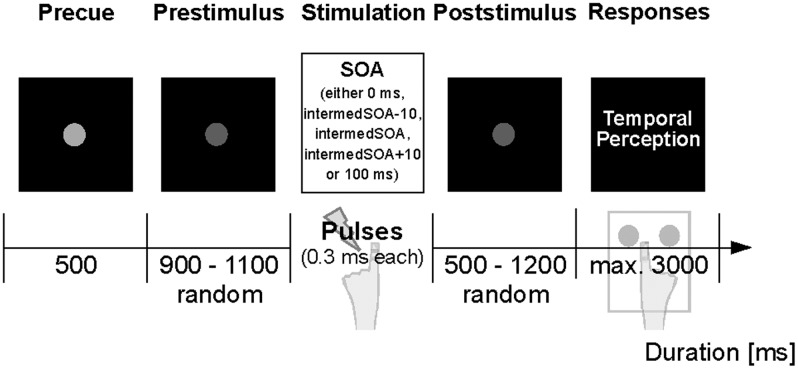
Experimental paradigm. The experiment started with a central fixation dot serving as start cue. A decrease in luminance after 500 ms signaled the start of the prestimulus epoch (jittered period of 900–1100 ms). Subsequently, electrotactile stimulation was applied to the left index finger with varying SOAs (0 ms, intermedSOA-10, intermedSOA, intermedSOA+10, 100 ms). Following a jittered poststimulus period (500–1200 ms), written instructions indicated the response window and subjects had to report their perception of the stimulation (perceived one stimulus vs. two stimuli) by button-press.